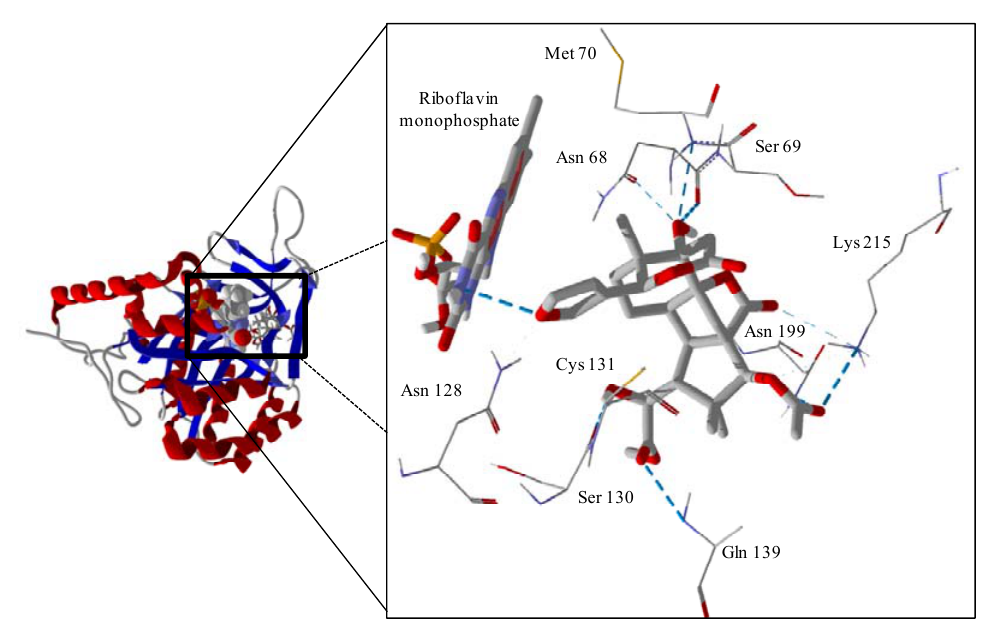
Figure 25. Lowest-energy docked pose of grandifontane with L. major dihydroorotate dehydrogenase (LmajDHODH, PDB 3mhu) showing key interactions with Cys 131, Asn 199, Asn 68, Ser 69, and Gln 139. Hydrogen-bonds are shown as blue dashed